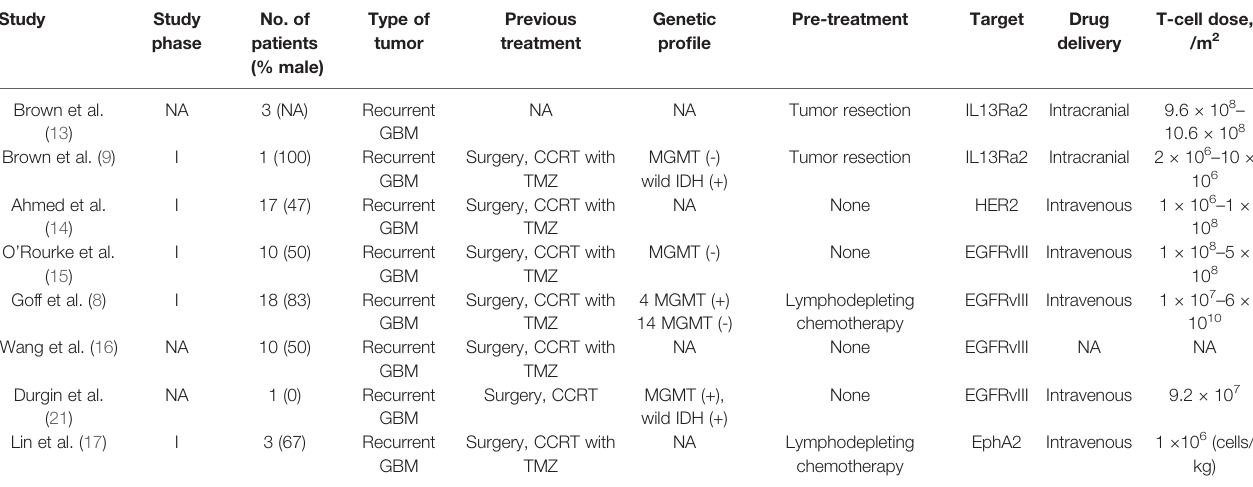
TABLE 1 | Characteristics of the included studies.